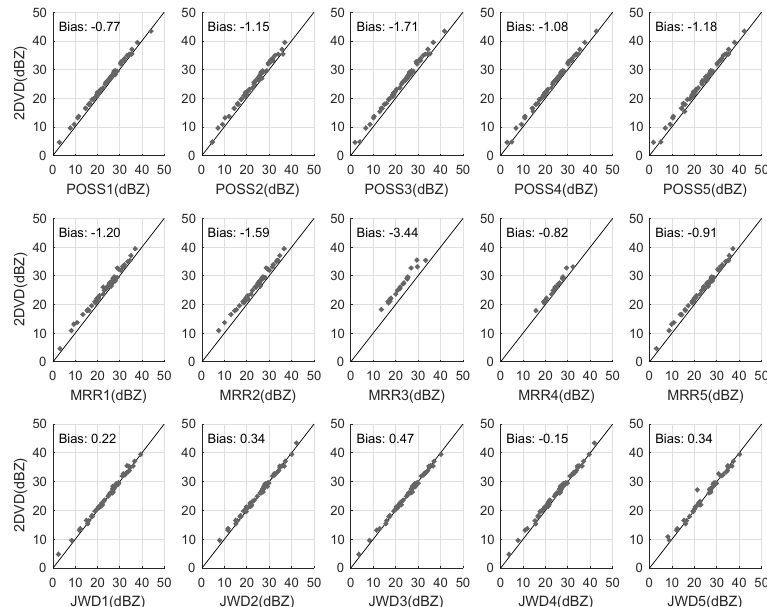
Figure 5. The hourly mean reflectivity (dBZ) from each disdrometer. The mean bias (dB) values of POSS, MRR and JWD compared to 2DVD are shown for each disdrometer on the top of each panel. Table 4. Bias values and their mean for each disdrometer calculated from hourly and one-minute rainfall rate and